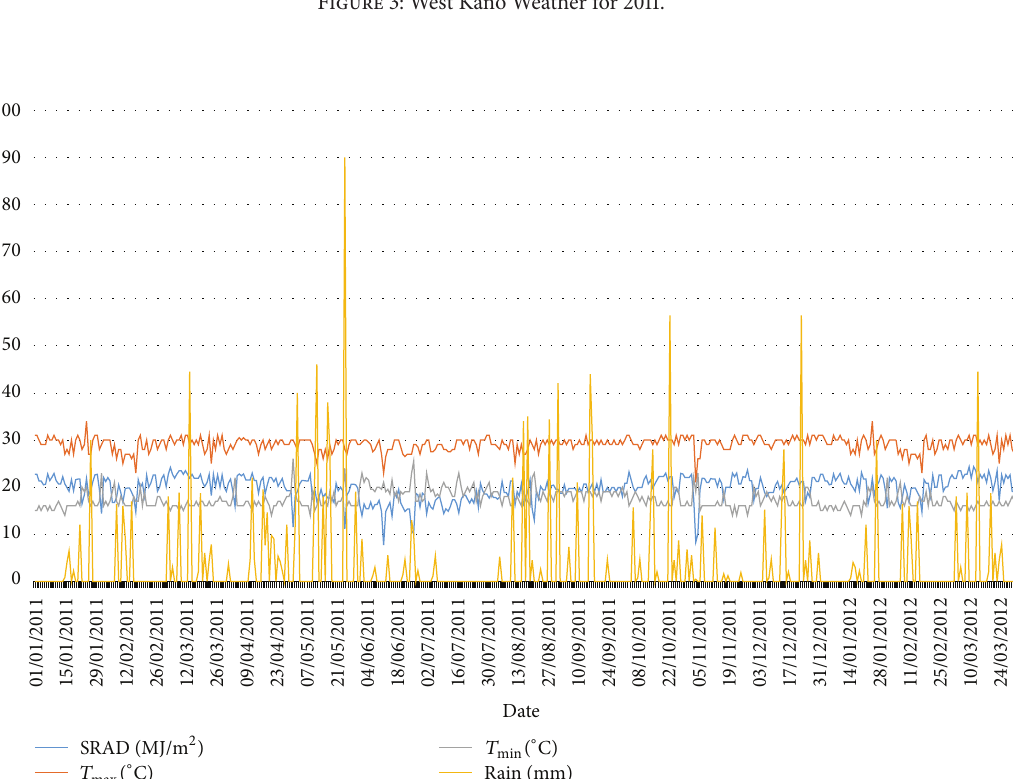
Figure 4: Bunyala weather for